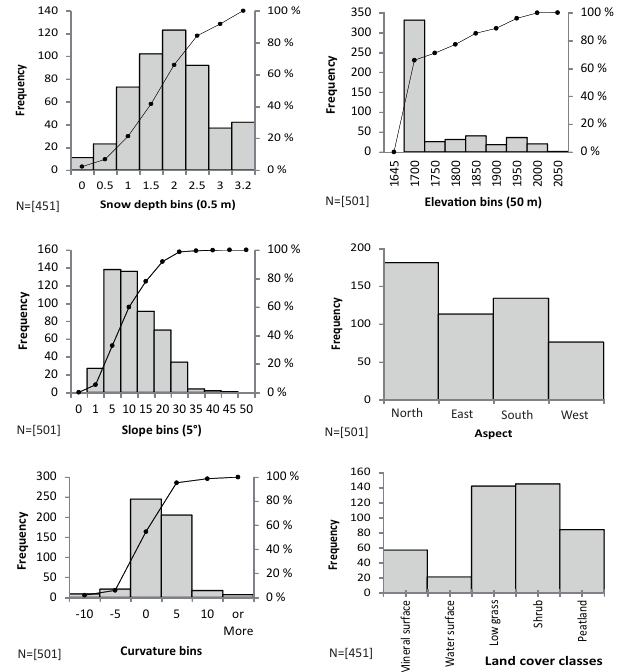
Figure 4. Distribution of the snow-probe sampling, according to the snow depth, the elevation, the slope, the aspect, the curvature, and the land-cover classes. On the whole snow-probe sampling ( N = 501), the snow probe did not reach the ground for 50